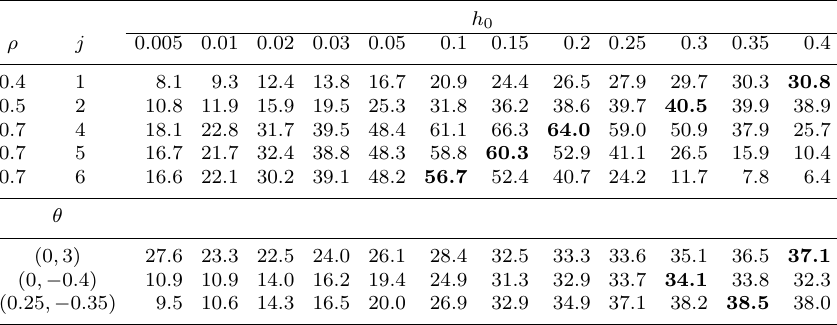
Table 4. AR (1) case with φ = 0 . 3 ( M 1 model). Simulated power for alternatives g 1 and g 2 with n = 50 and 10,000 replications; h = h 0 n − 1 / 4 , kernel U [ − 1 , 1].